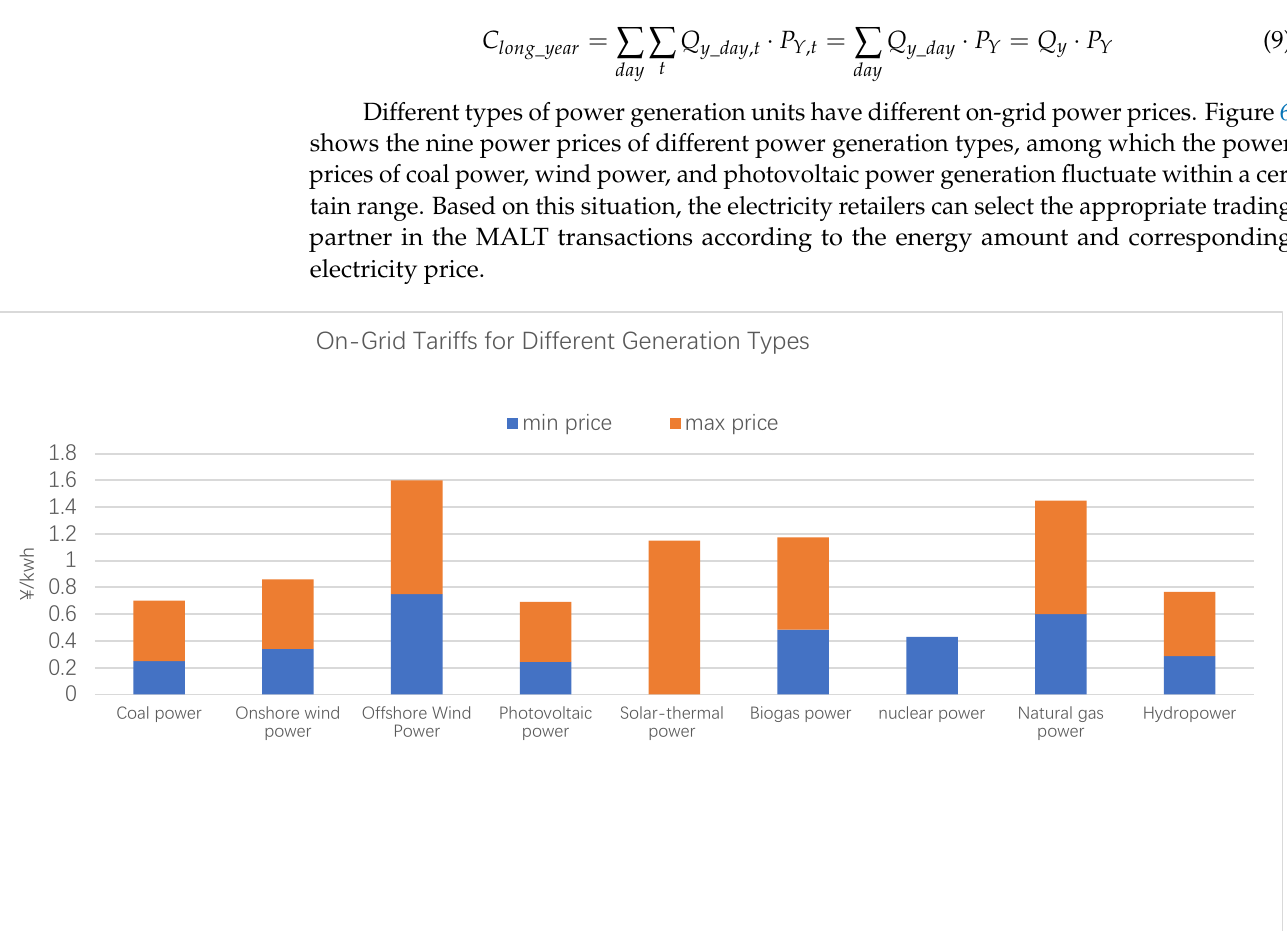
Figure 6. On-grid electricity prices of different power generation types. The researchers studied the relationship between the electricity price elasticity coef- ficient and social economic development in Refs. [22 , 23]. The researchers studied the ef- fects on residential load power consumption due to electricity price changes at different times in Refs. [24–26]. The demand elasticity coefficient of electricity price represents the relationship between energy demands and electricity price, as shown in Formula 10. Q Δ Δ is the electricity fluctuation, and P is the is electricity. P is the electricity price. electricity price fluctuation.